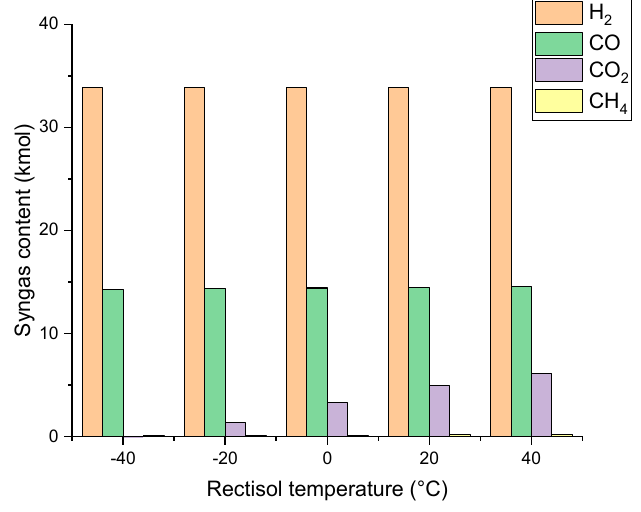
Figure 6. E ff ect of Rectisol temperature on syngas composition (40 bar). Figure 6. Effect of Rectisol temperature on syngas composition (40 bar).